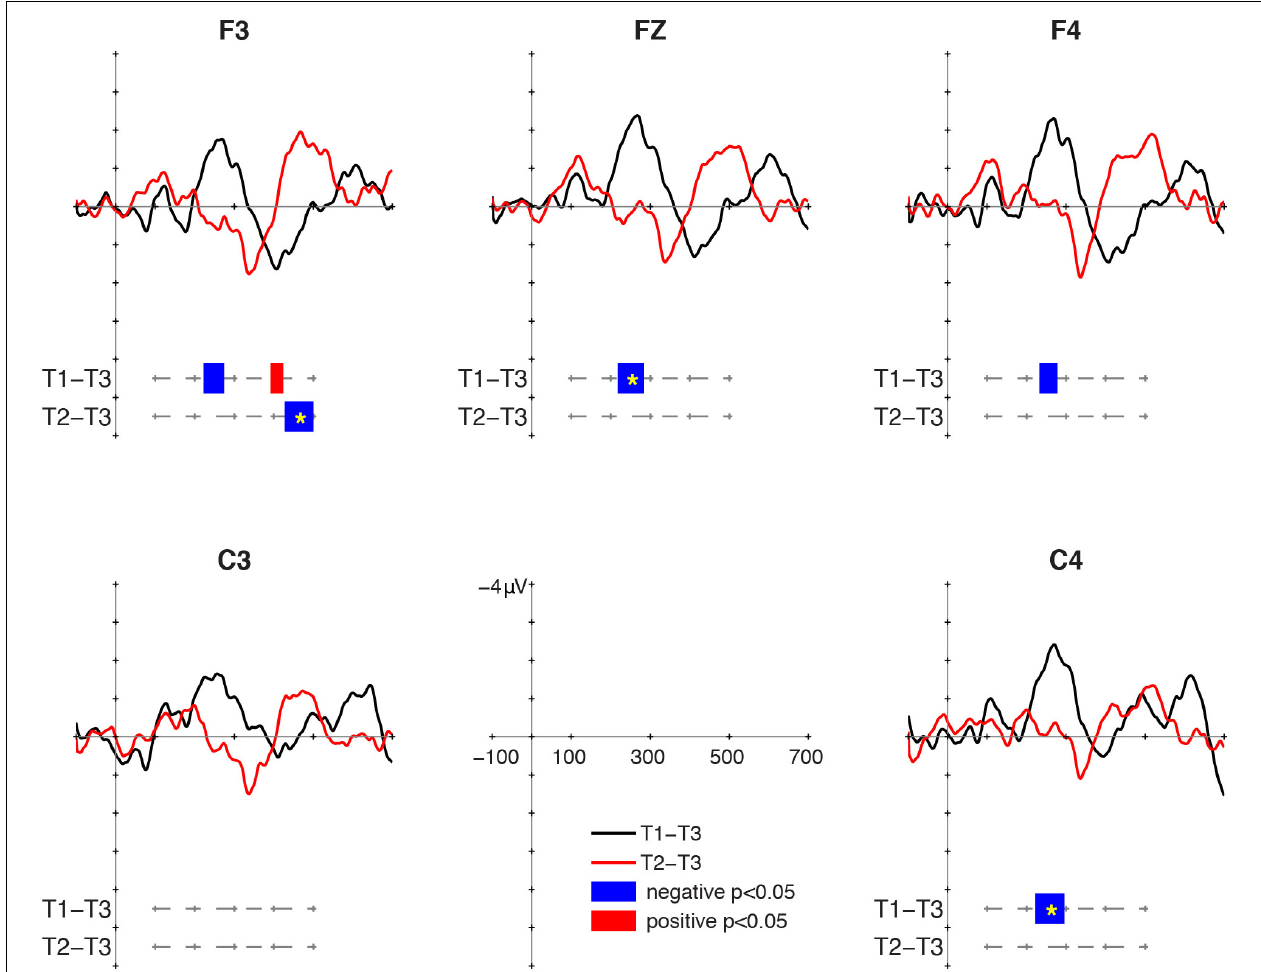
FIGURE 3 | Mismatch responses (MMRs) at 24 months of